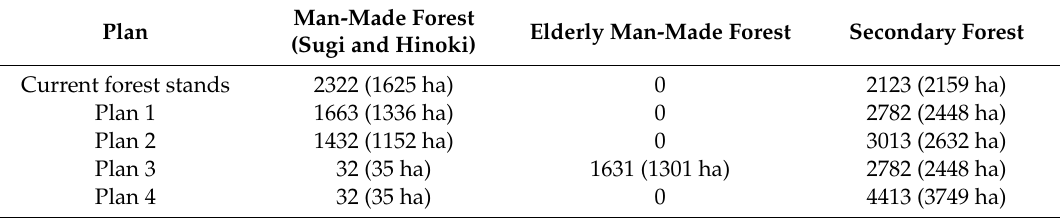
Figure 10. Current man-made forest stands and secondary forest stands. Table 1. Changes in the number of forest stands and forest areas in the four plan simulations. Man-Made Forest Plan Elderly Man-Made Forest Secondary (Sugi and Hinoki)